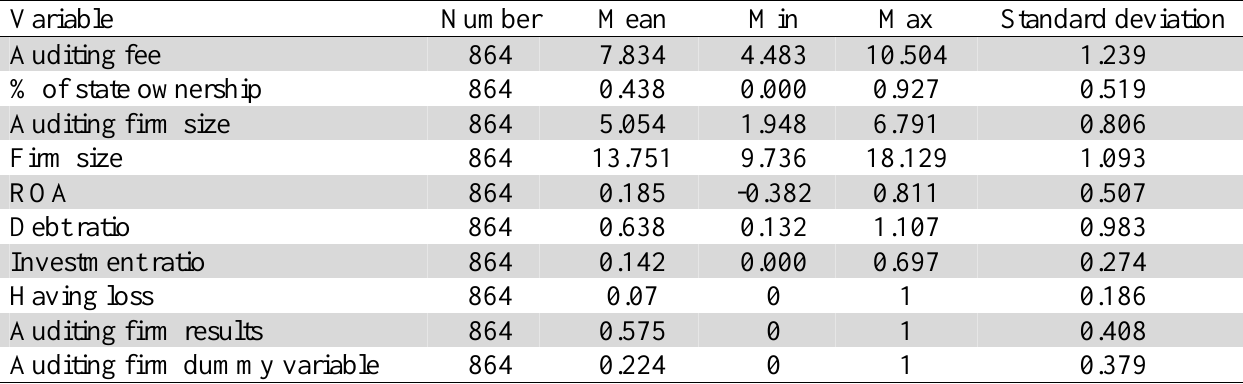
The summary of some basic